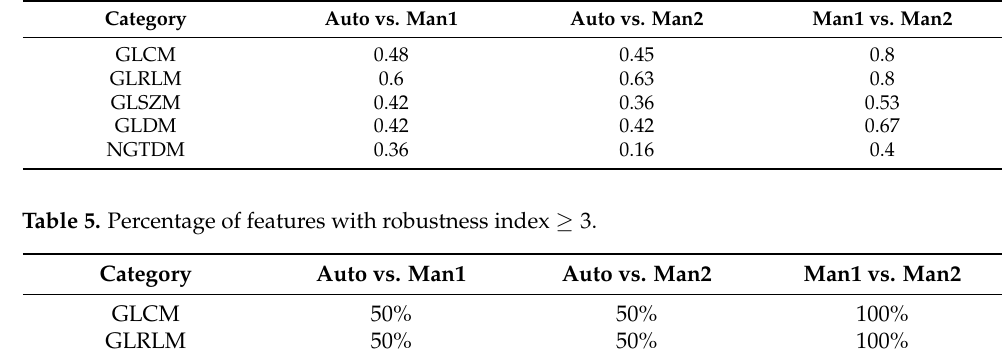
Table 4. Overall feature category robustness across the three segmentation raters.